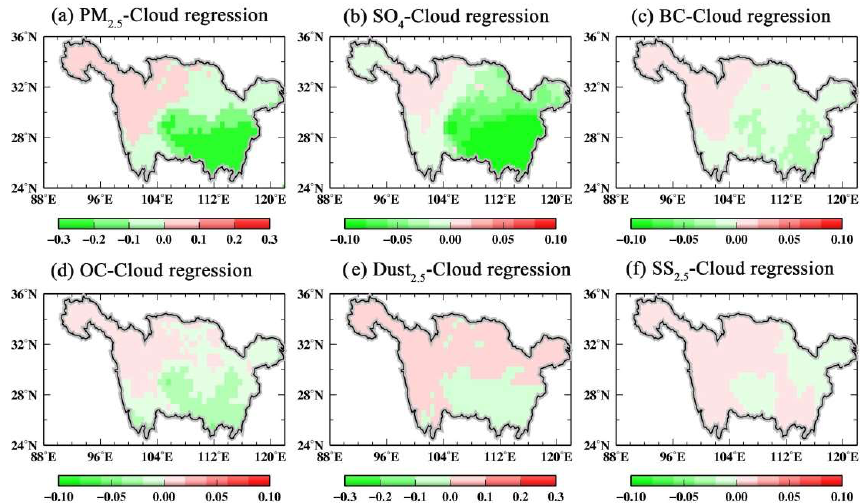
Figure 16. Multiple linear regression coefficients ( β 5 ) of each PM 2.5 component with total cloud cover (cloud), in units of µ g m − 3 % − 1 . ( a – f ) refer to the regression coefficients of PM 2.5 , SO 4 , BC, OC, Dust 2.5 and SS 2.5 with total cloud cover, respectively.